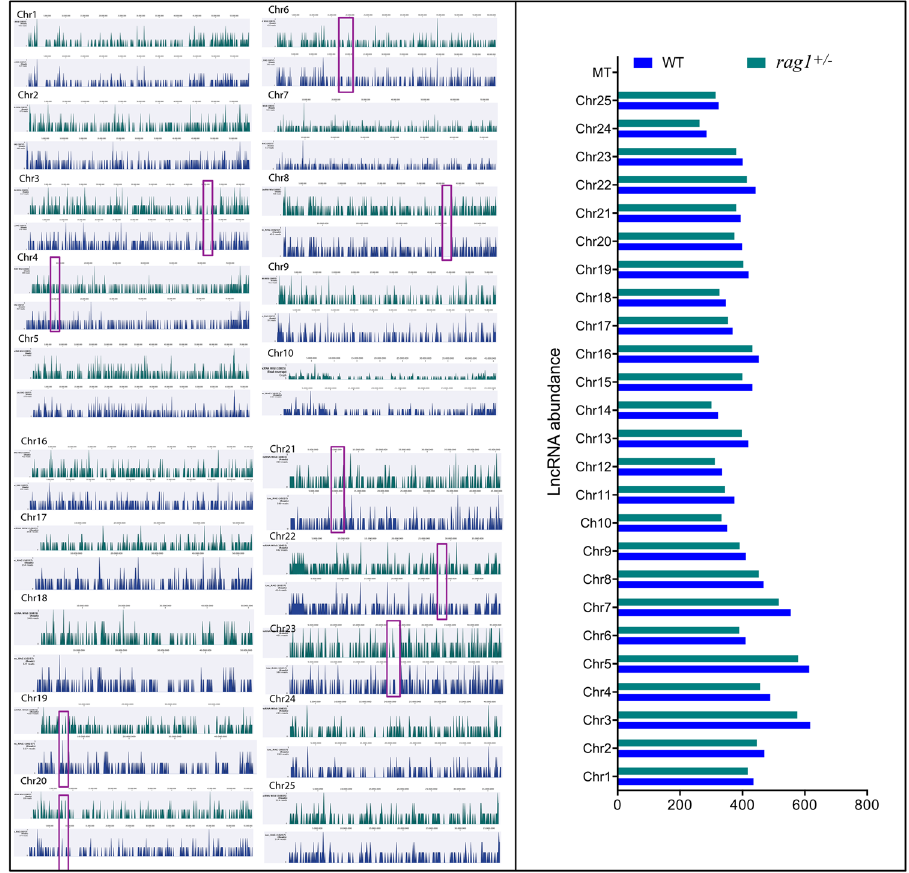
Figure 3. LncRNA abundance and chromosome localization in WT and rag1 + / − zebrafish. LncRNAs were mapped in the zebrafish genome to identify potential differences in the chromosome location between WT and rag1 + / − zebrafish. In general terms, lncRNAs from both lines showed a similar chromosome distribution and abundance per chromosome. Nevertheless, some subtle differences were observed, revealing the specific position of WT and rag1 + / − exclusive